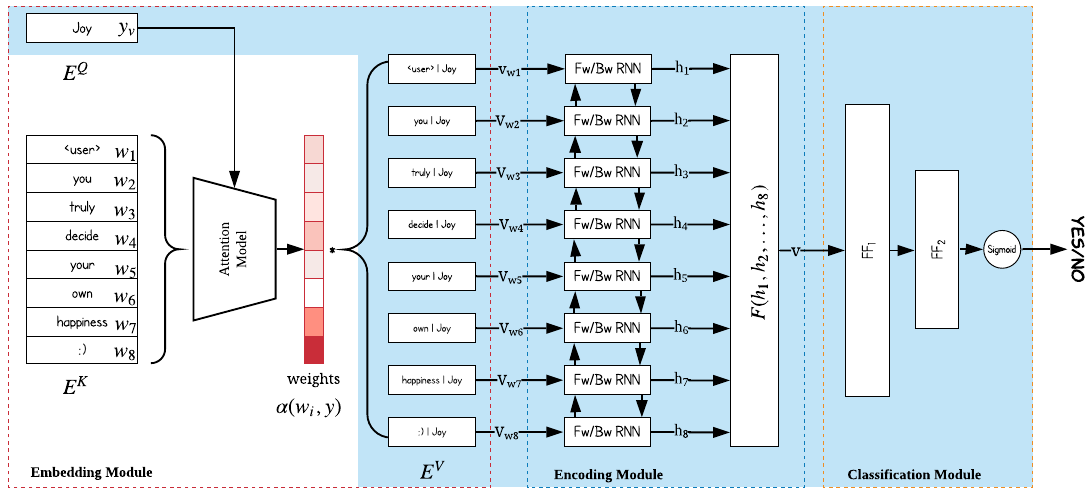
Figure 2. An illustration of the proposed system. Shaded parts are trainable. Fw and Bw refer to the Forward and Backward cells respectively, and FF means Feed-Forward